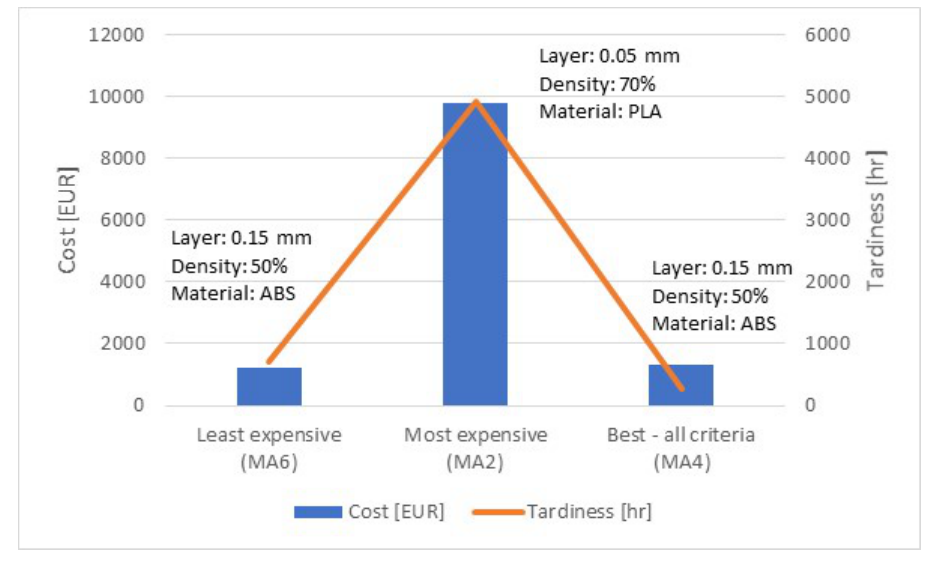
Figure 9. Test Case 1—Cost and tardiness of different configurations.